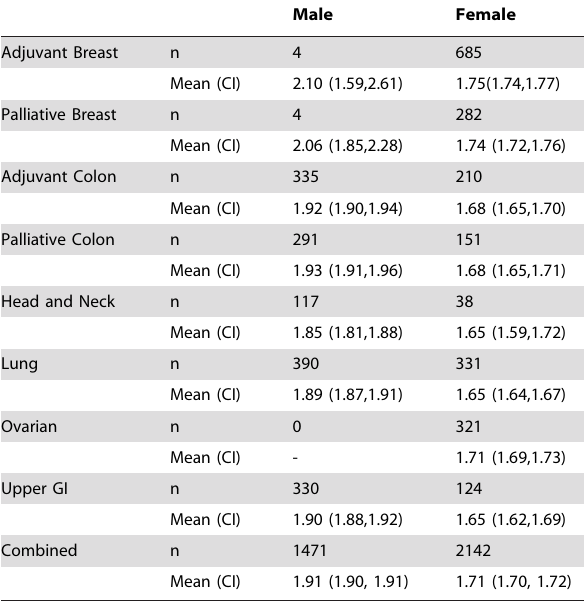
cell lung cancer. In both cases the manufacturers assumed that doses of docetaxel could be calculated on the basis of a mean BSA of 1.7 m 2 for all patients (male and female). The costs of pemetrexed were calculated on a similar basis (erlotinib in tablet form does not require dose adjustment according to BSA). On this basis, it appeared that the extra cost of switching to pemetrexed is £ 3,006 per patient and for erlotinib is £ 1,865 per patient. However, the calculations employed a relatively low mean BSA, and did not take into consideration the effects of the distibution of BSA values in the population. The latter may have a significant effect on the final estimate of incremental cost, due mainly to effects on vial usage. Chemotherapy agents are frequently marketed in large vial sizes, leading to a stepwise rather than continuous increase in vials (and hence cost) with increasing BSA. Although vial sharing may help prevent wastage, this is only possible in relatively large centres for more common tumour types, and may be affected by the stability of the agent.